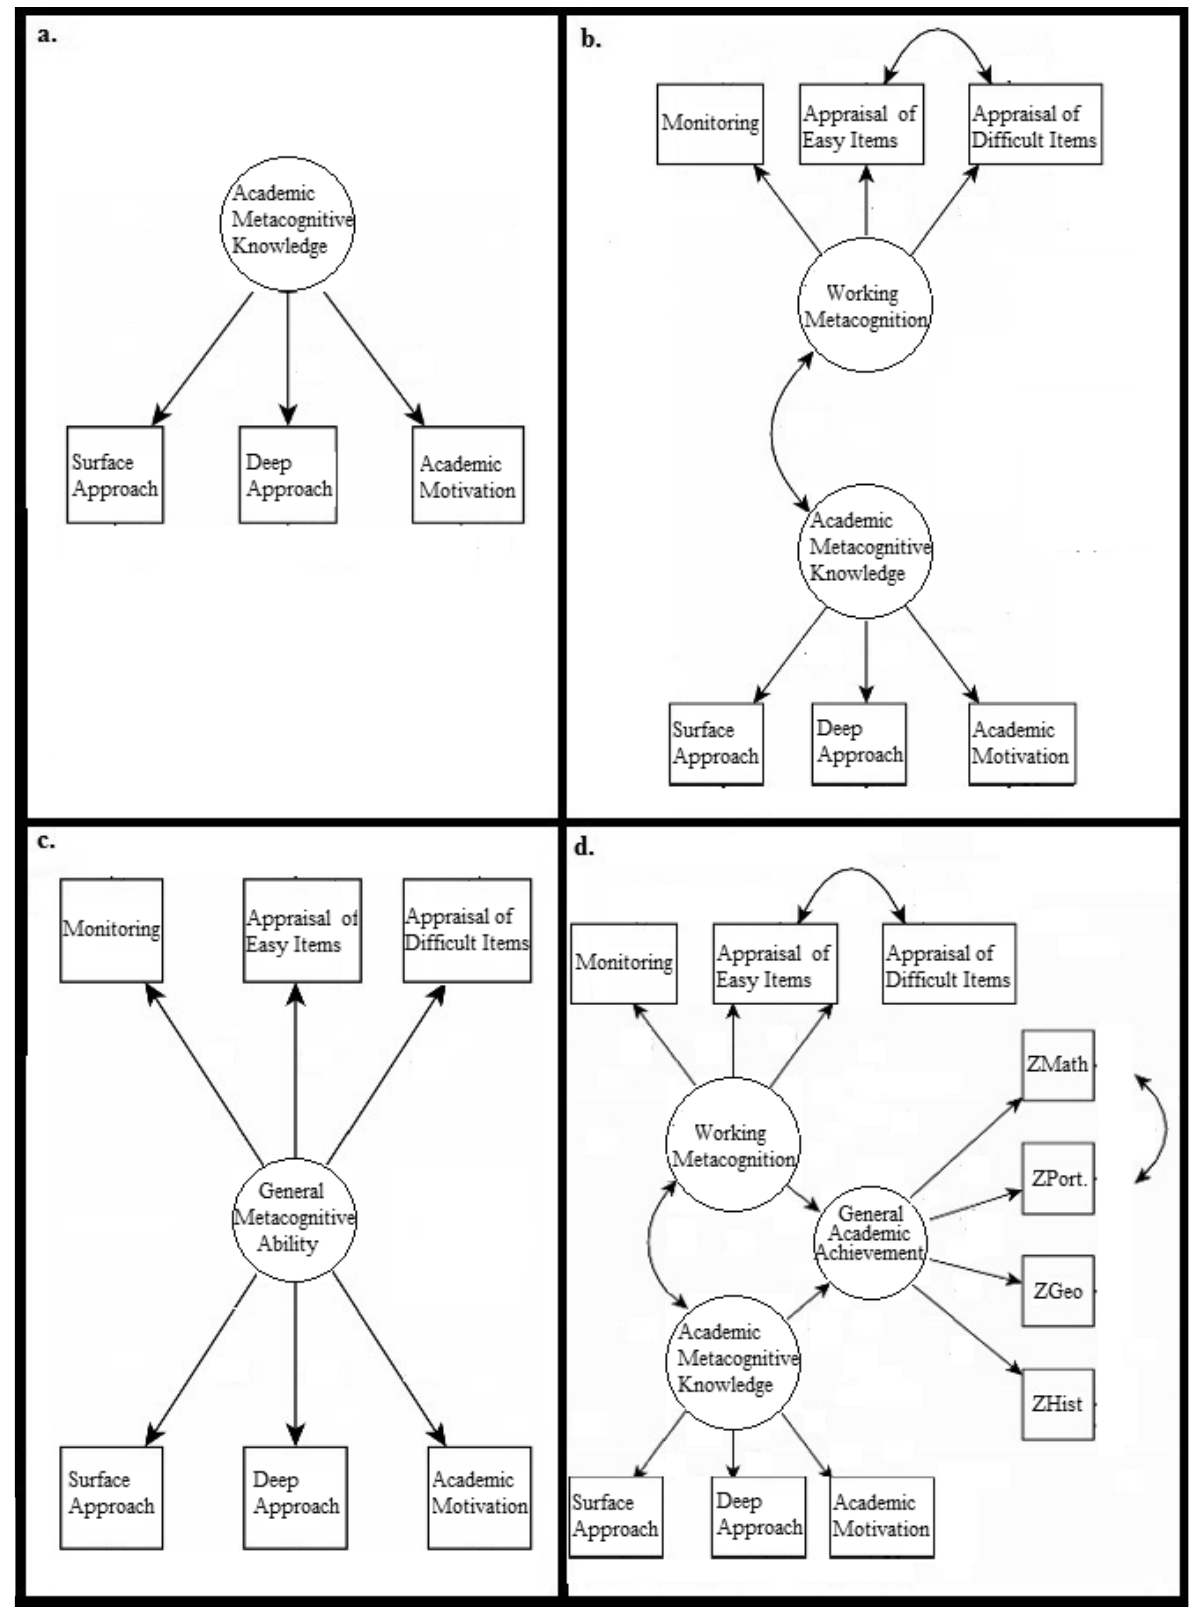
Figure 1 . Models: (a) Academic metacognitive knowledge model; (b) Distinctive model; (c) Concurrent model; (d) General academic achievement predictors